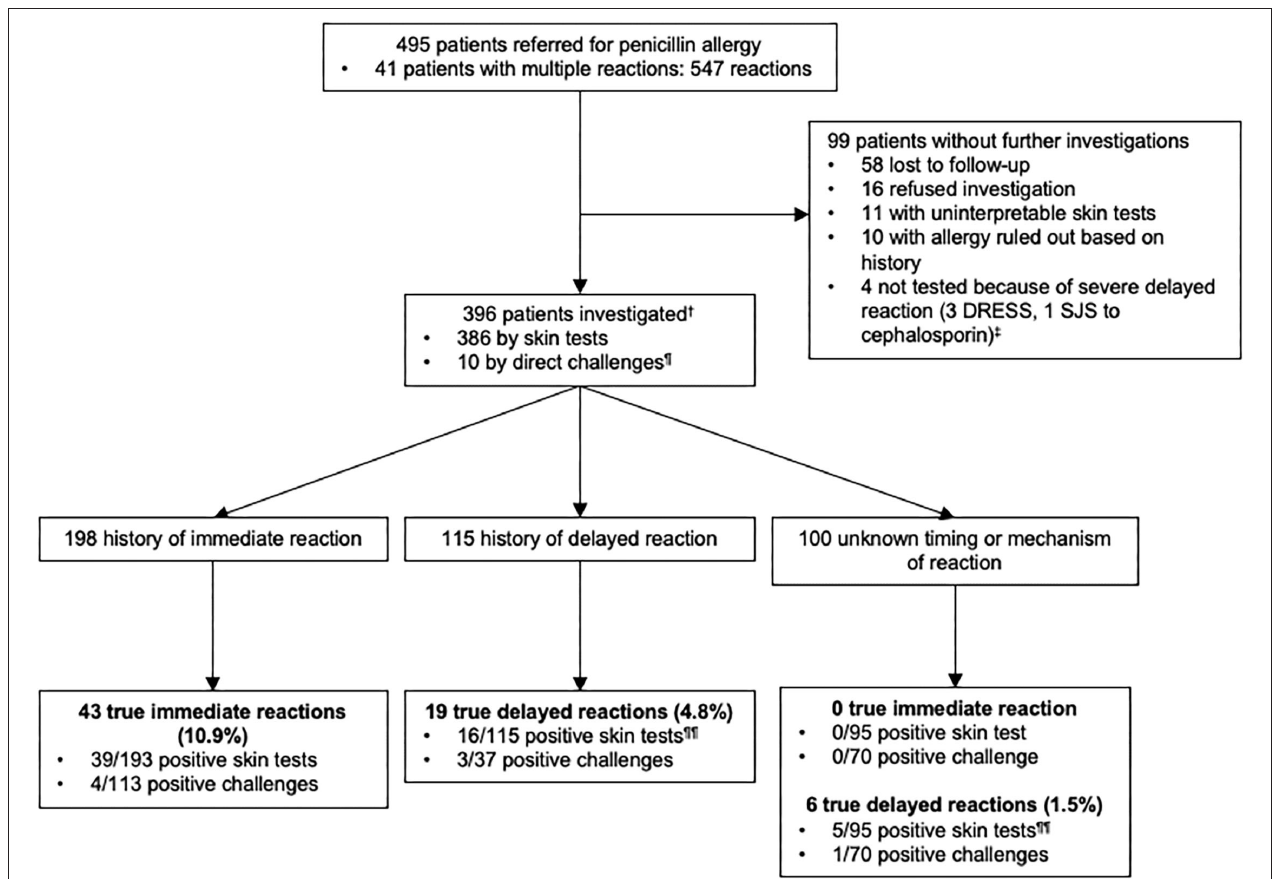
FIGURE 2 | Outcomes of testing in 396 patients with a history of penicillin allergy. † Among 396 patients who were studied for a history of allergy to penicillin antibiotics, some of them had multiple reactions and were included in more than one group. ‡ 1 patient reported a delayed-type reaction with a penicillin but did not underwent skin tests because he had a SJS with a cephalosporin. ¶ 5 patients had negative direct drug challenge without prior skin testing (5 direct for suspicion of an immediate-type reaction and 5 for reaction of unknown timing or mechanism of the reaction-type). Direct drug challenges were performed on the basis of the physician’s assessment because the risk of a reaction was highly unlikely. ¶¶ 3 patients with a confirmed allergy, reported multiple allergic reactions to penicillin antibiotics and were included both in delayed and unknown timing or mechanism of the reaction groups according to the clinical description of the reactions. DRESS, Drug Reaction with Eosinophilia and Systemic Symptoms; SJS, Stevens-Johnson